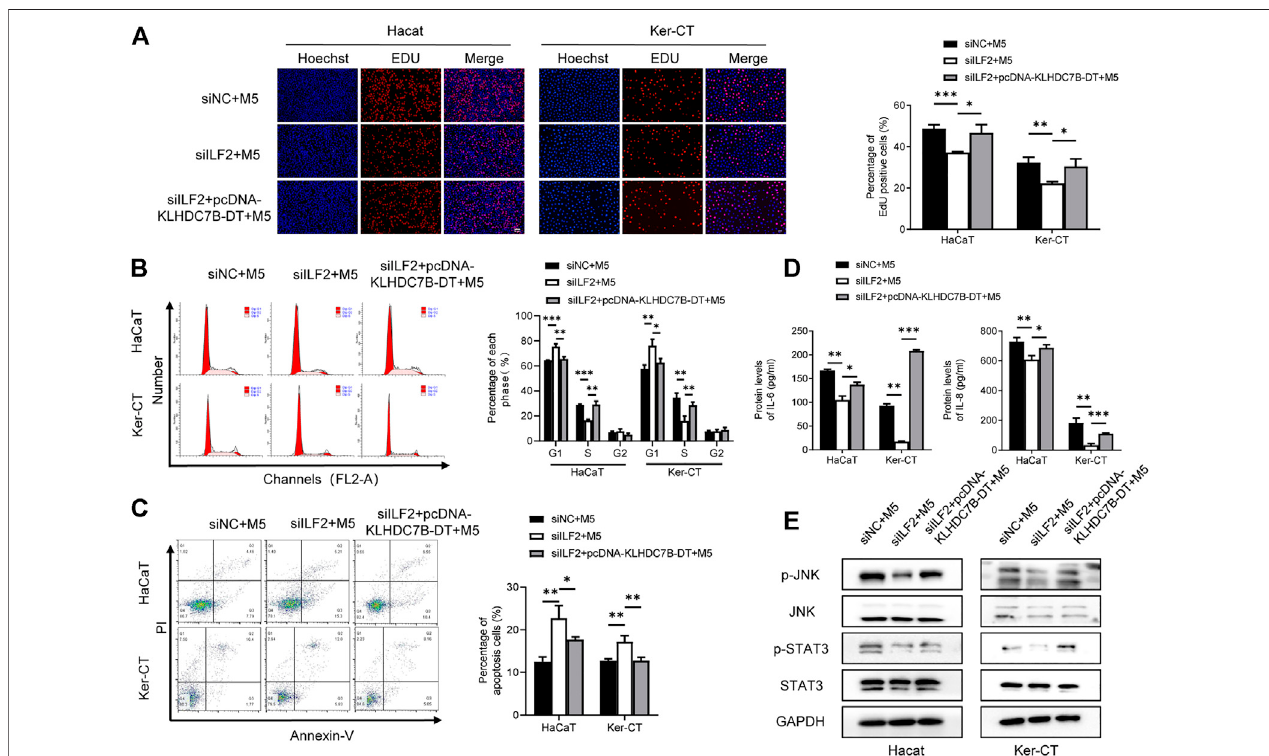
FIGURE 6 | ILF2 promotes hyperproliferation and in fl ammation through STAT3/JNK pathways in M5-induced keratinocytes. (A) Using an EdU assay, the proliferative effects of M5-induced keratinocytes were detected after transfection with siILF2 and siILF2+pcDNA-KLDHC7B-DT. (B) The cell cycle was detected by fl ow cytometry through PI staining. (C) Cell apoptosis was detected by fl ow cytometry through Annexin-V/PI staining. (D) Protein levels of IL-6 and IL-8 were detected by ELISA. (E) Activation of the STAT/JNK pathway detected by Western blotting. Data are shown as the means ± SD, * p < 0.05, ** p < 0.01, *** p < 0.001. All experiments were repeated at least three